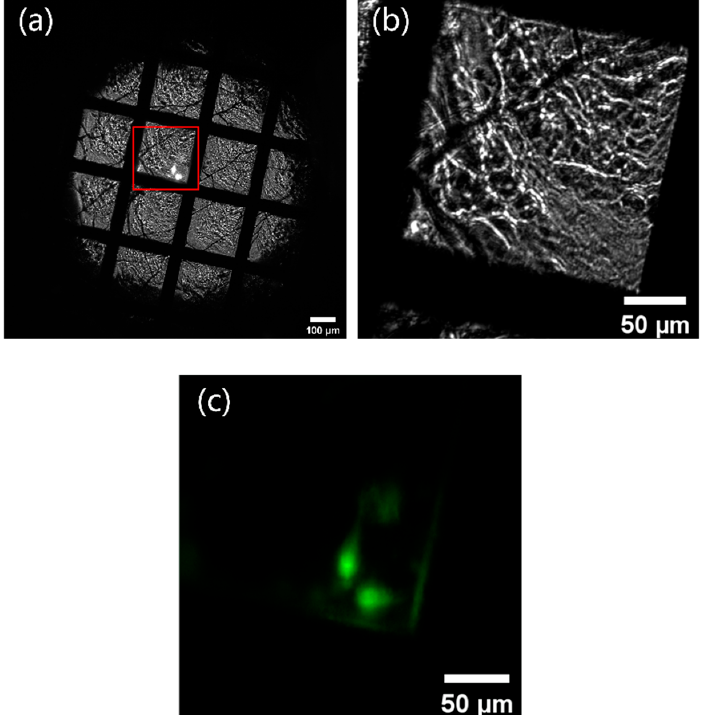
Figure 3. The images collected by on-line FM installed at BL07W@NSRL. ( a ) bright-field images of the cryogenic sample grid captured by sCMOS when the laser was turned on; ( b ) bright-field images of the red box area in Figure 3a when the laser was turned off; ( c ) fluorescent image of the grid in ( b ). All acquired images were taken with the on-line 10 × objective.